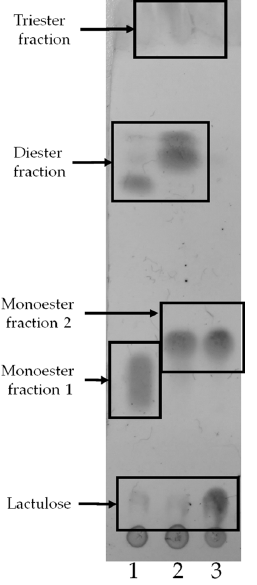
Figure 4. TLC analysis for products profile in a one ‐ hour reaction, using vinyl laurate as acyl donor (150 mM) and lactulose (30 mM) in organic solvent. Lines: (1) Novozym 435, (2) Lipozyme TL IM, and (3) Lipozyme from Mucor miehei